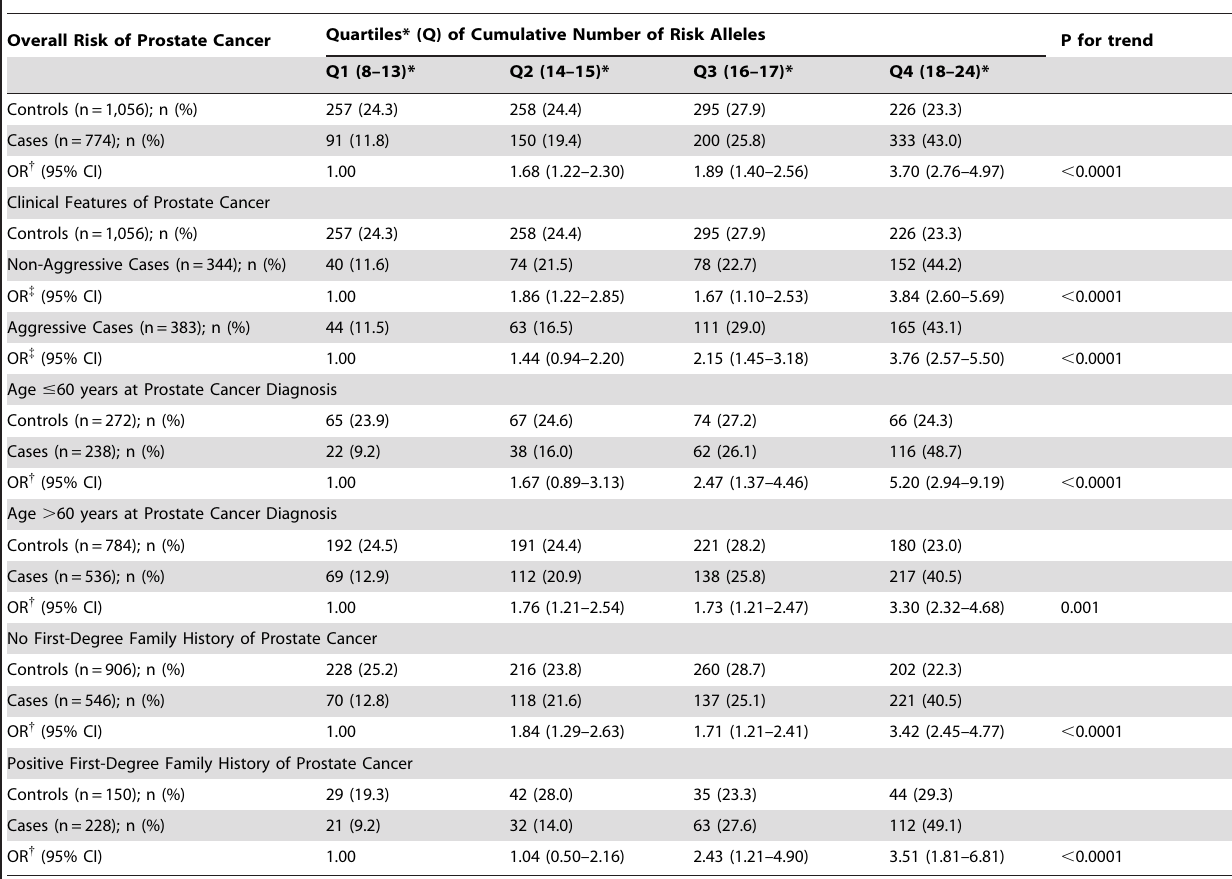
Table 3. Associations of cumulative number of risk alleles with overall prostate cancer, and stratified by clinical features, age at diagnosis and family history of prostate